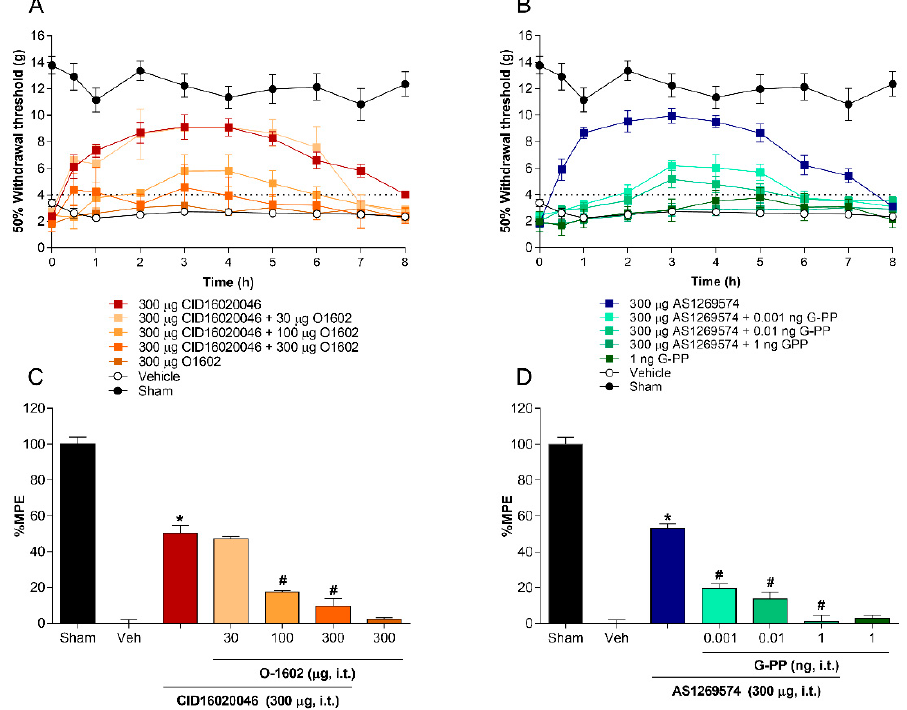
Figure 3. Effect of increasing doses of O-1602 (selective GPR55 agonist; ( A , C )) and G-protein antagonist peptide ( B , D ) on antiallodynic effect induced by CID-16020046 (selective GPR55 antagonist; ( A , C )) and AS-1269574 (selective GPR119 agonist; ( B , D )), respectively, in L5-L6 spinal nerve ligation-induced neuropathic rats. Data represent the mean ± SEM of six animals per group. * Significantly different from the vehicle group and # significantly different from CID-16020046 or AS-1269574 group by one-way analysis of variance, followed by post hoc Dunnett’s test with p < 0.05. Abbreviations: %MPE = percentage of maximum effect possible .